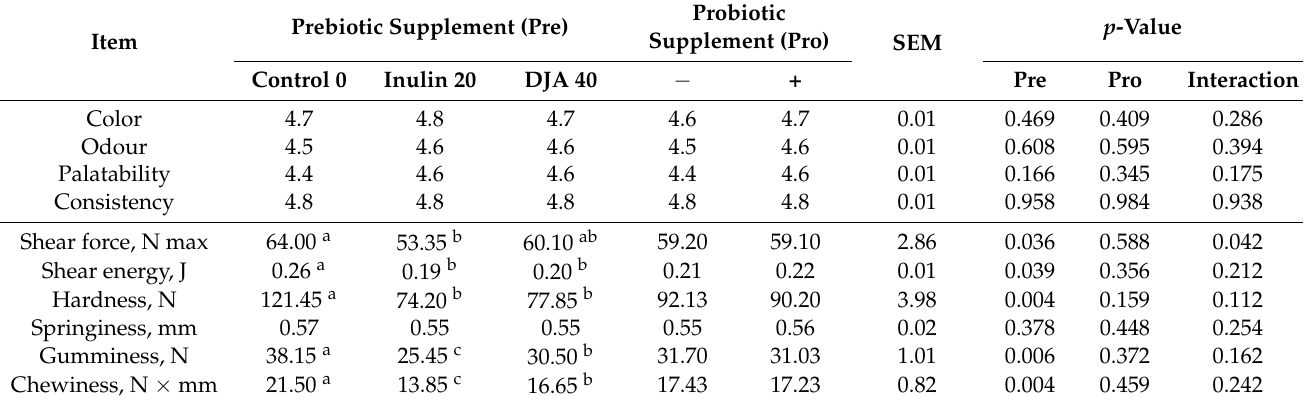
Table 6. Texture parameters and sensory meat quality of cooked meat (m. longissimus